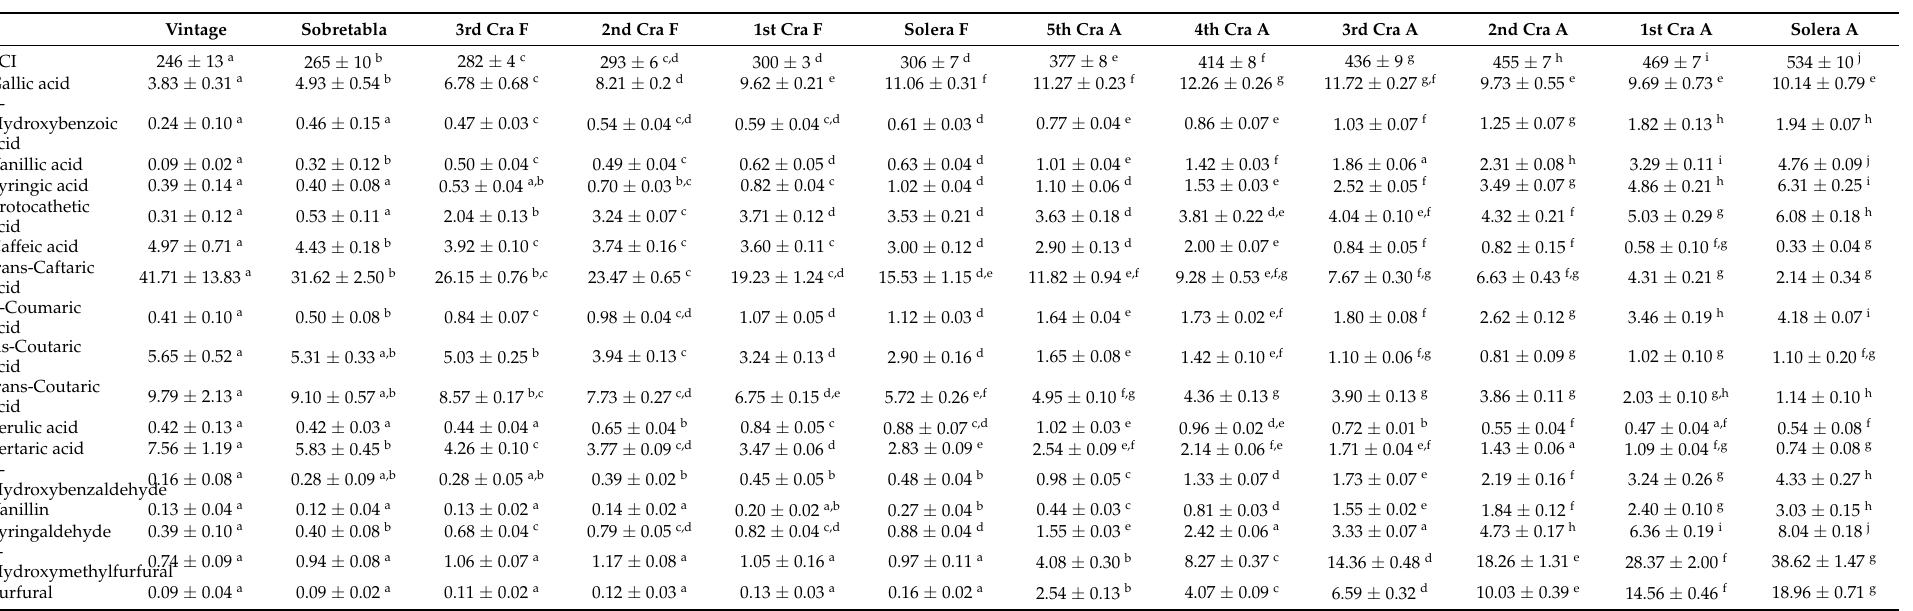
Table 7. Folin-Ciocalteau Index FCI (mg gallic acid/L) and concentration of phenolic compounds (mg/L) in the Sobretabla, Fino and Amontillado wines studied.